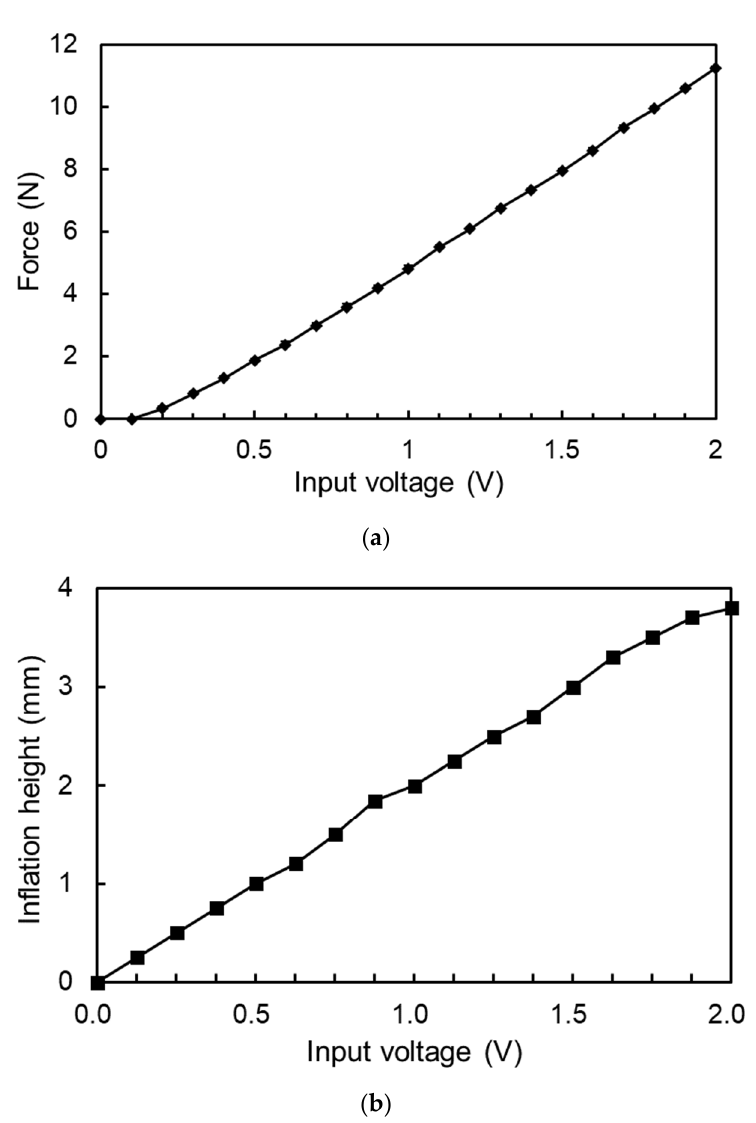
Figure 7. ( a ) Force and ( b ) inflation height of a balloon in the normal direction at various input Figure 7. Force ( a ) and inflation height ( b ) of a balloon in the normal direction at various input voltages.